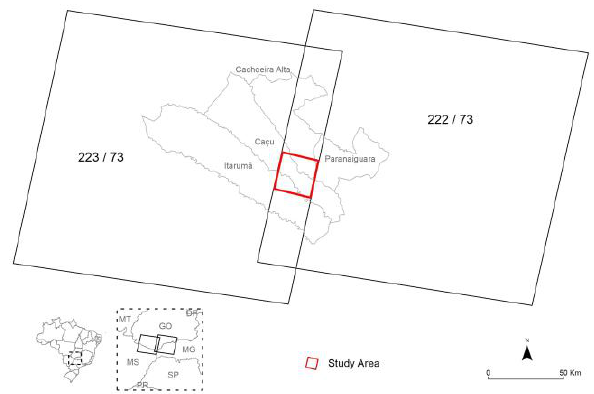
Figure 2. Overlaying Landsat swath and study area.